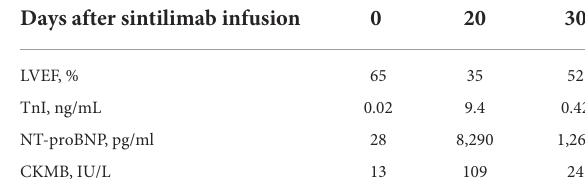
TABLE 1 The chronological changes of major